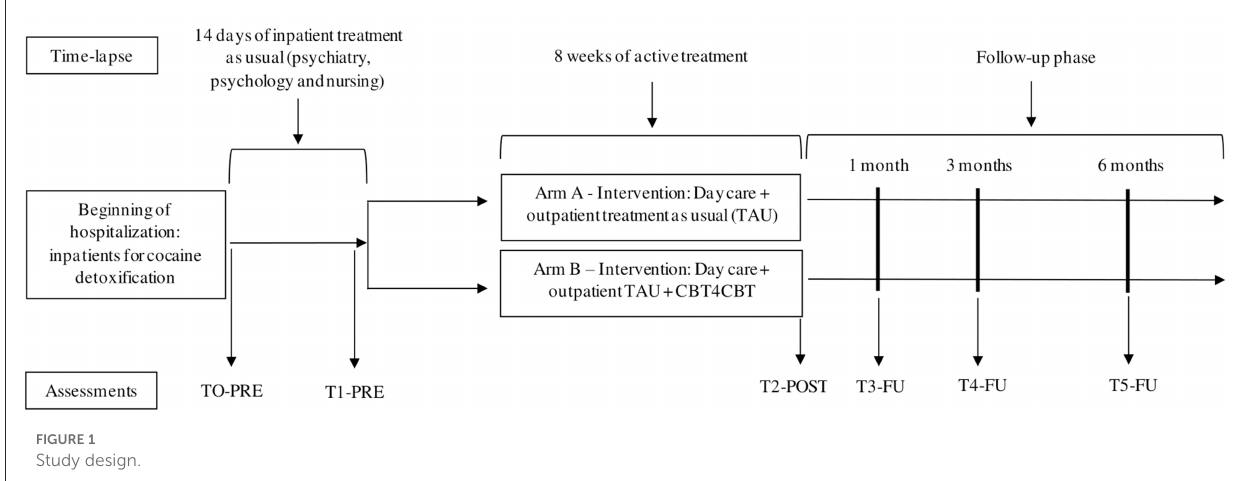
FIGURE1 Study design.